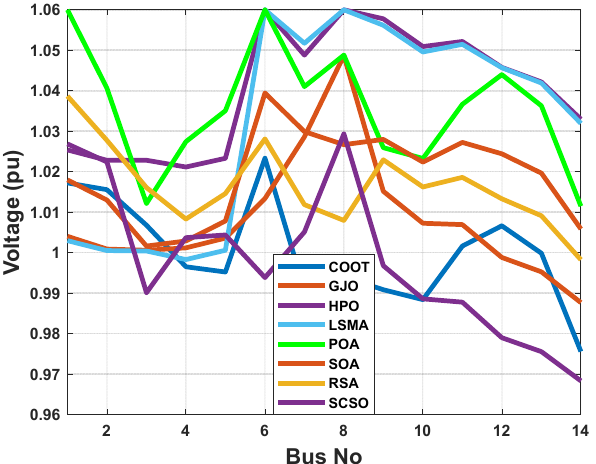
Figure 7. The voltage profile of the POA and other compared algorithms for case 2 in a standard IEEE 14-bus test system.